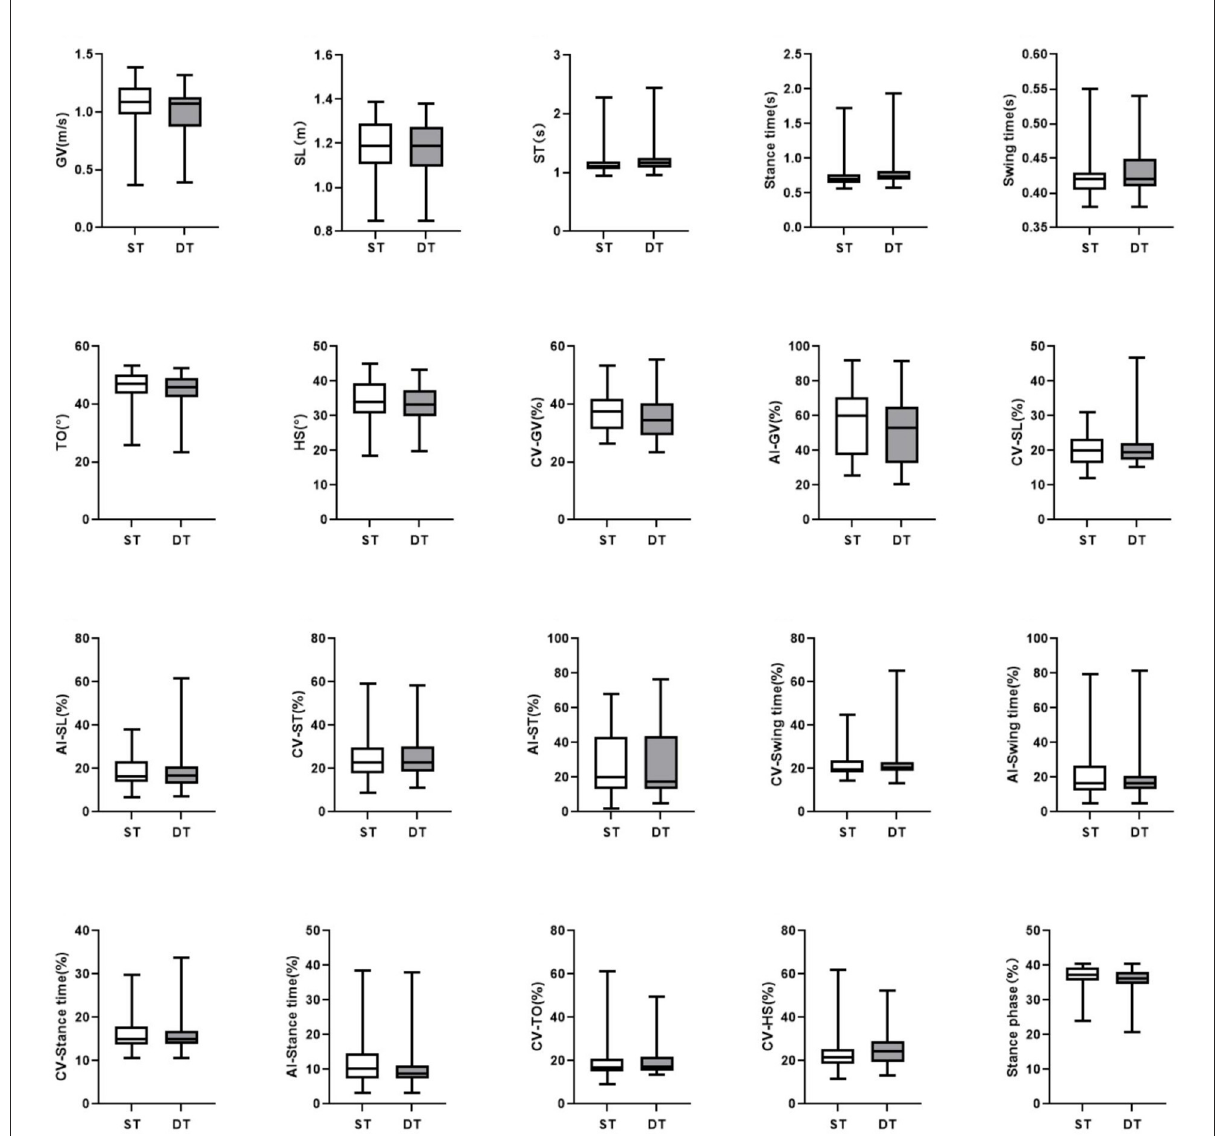
FIGURE2 The comparisons of gait characteristics of healthy adults in single task walking and dual task walking. ST, single task; DT, dual task; PD, Parkinson’s Disease; HC, healthy control; GV, gait velocity; SL, stride length; ST, stride time; TO, toe-off angle; HS, heel strike angle; CV, coefficient of variation; AI, asymmetry index. All of the P-values were corrected using Benjamini–Hochberg multiple testing correction. ** p ≤